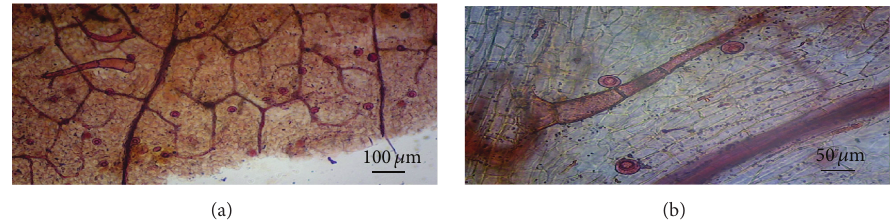
Figure 2: (a) Venation pattern in leaves of in vitro raised shoots; (b) multicellular, nonglandular trichome ( scale bar 50.0 𝜇 m, 100.0 𝜇 m).